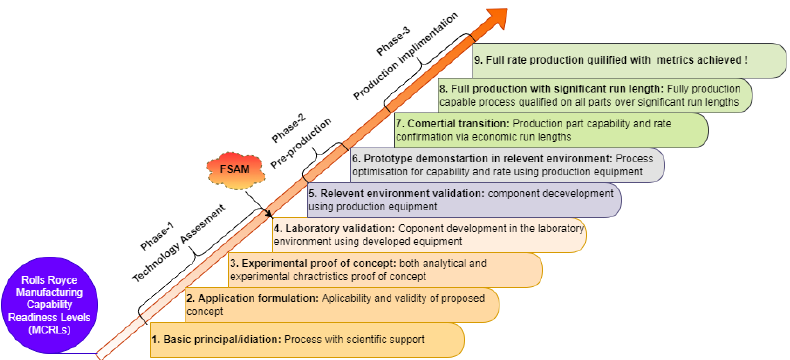
Figure 27. Rolls Royce manufacturing capabilities readiness levels (MCRLs) for TRL identification of FSAM.